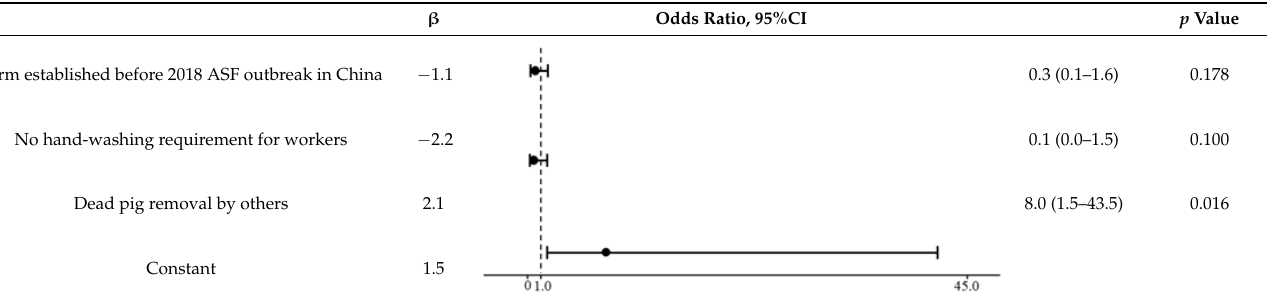
Table 3. Multivariable logistic regression model for potential risk factors selected from univariable analyses. β Odds Ratio, 95%CI p Value